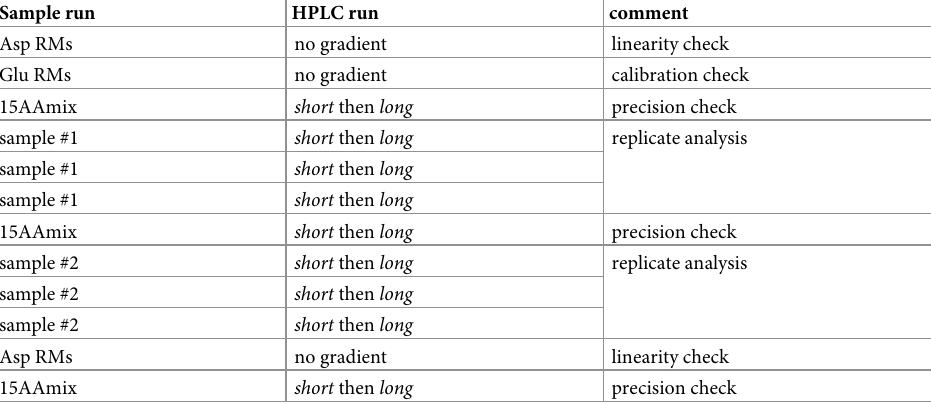
Table 2. A typical analytical sequence for two samples. Sample run